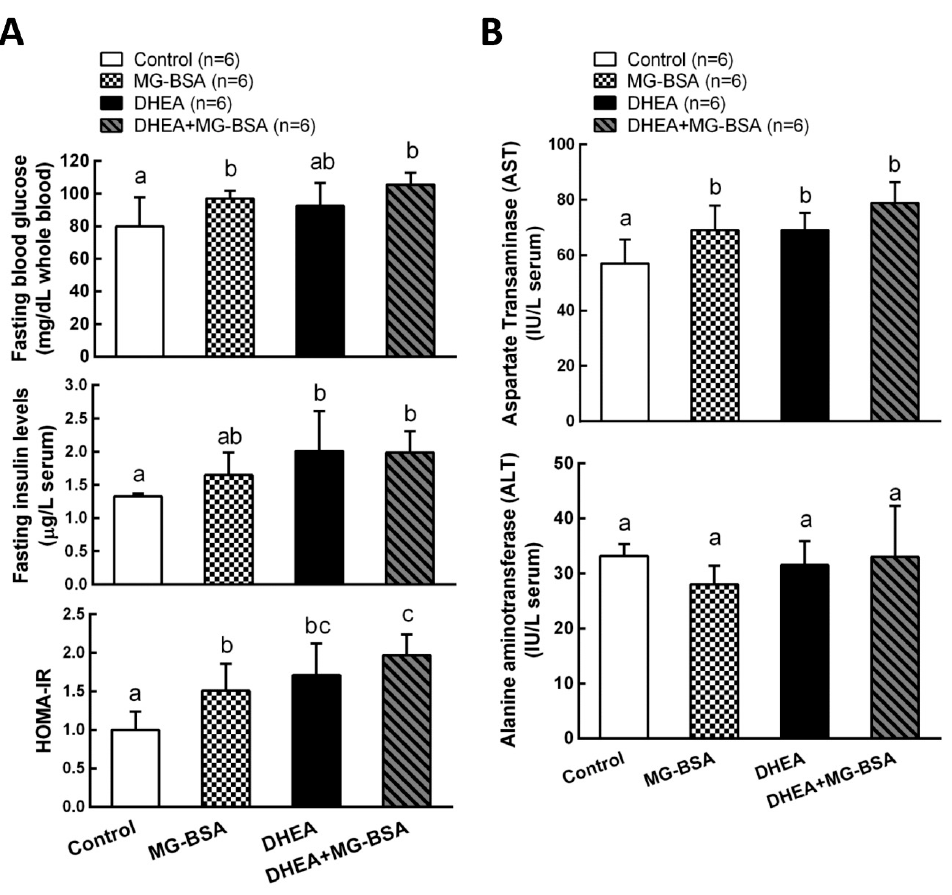
Figure 7. E ff ects of MG-BSA on glucose homeostasis and the liver functional index in DHEA-induced PCOS rats. Before sacrifice, rats were starved for 12 h. Blood was collected and then serum was isolated. ( A ) Serum glucose and insulin levels were measured. The homeostatic model assessment–insulin resistance (HOMA-IR) index was calculated via the formula: HOMA-IR = fasting insulin × fasting glucose / 405. ( B ) Serum AST and ALT levels were measured to evaluate the index of liver function. Data are represented as mean ± SD ( n = 8). Di ff erent letters indicate significant di ff erences among all groups ( p < 0.05).